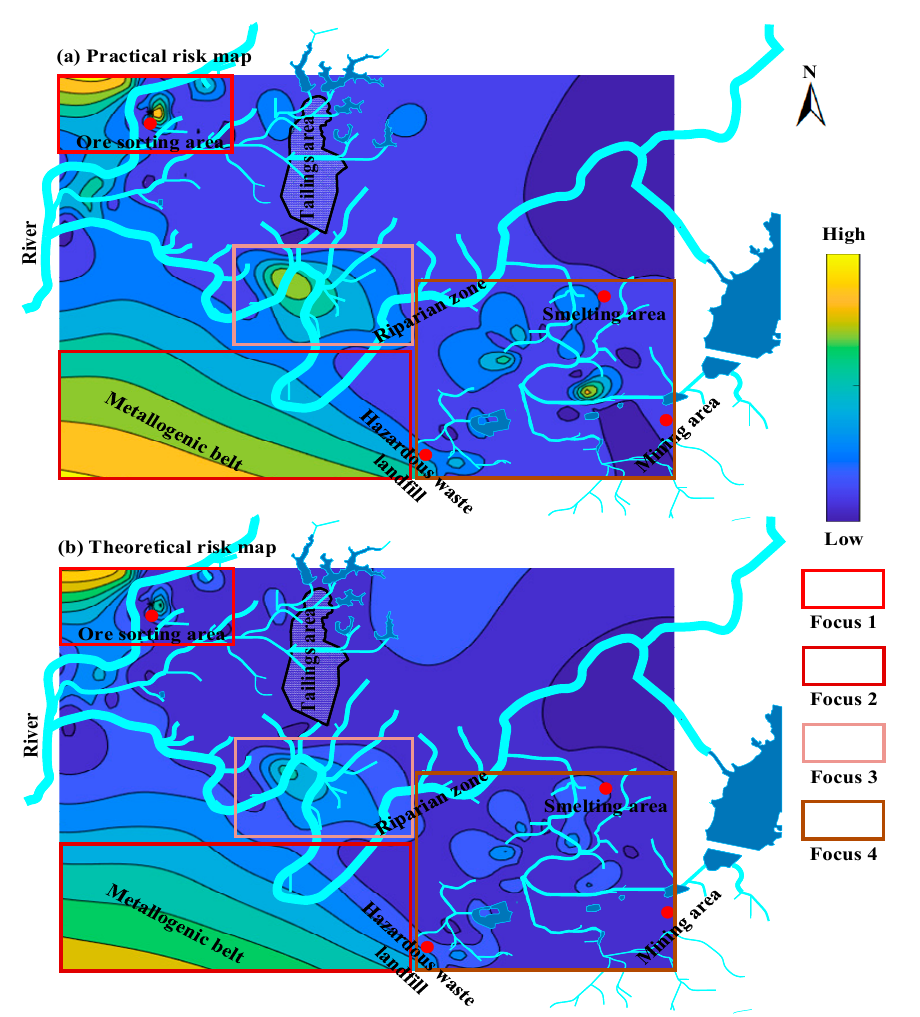
Figure 6. Spatial distribution of cadmium pollution risk in soil of abandoned lead/zinc mine.